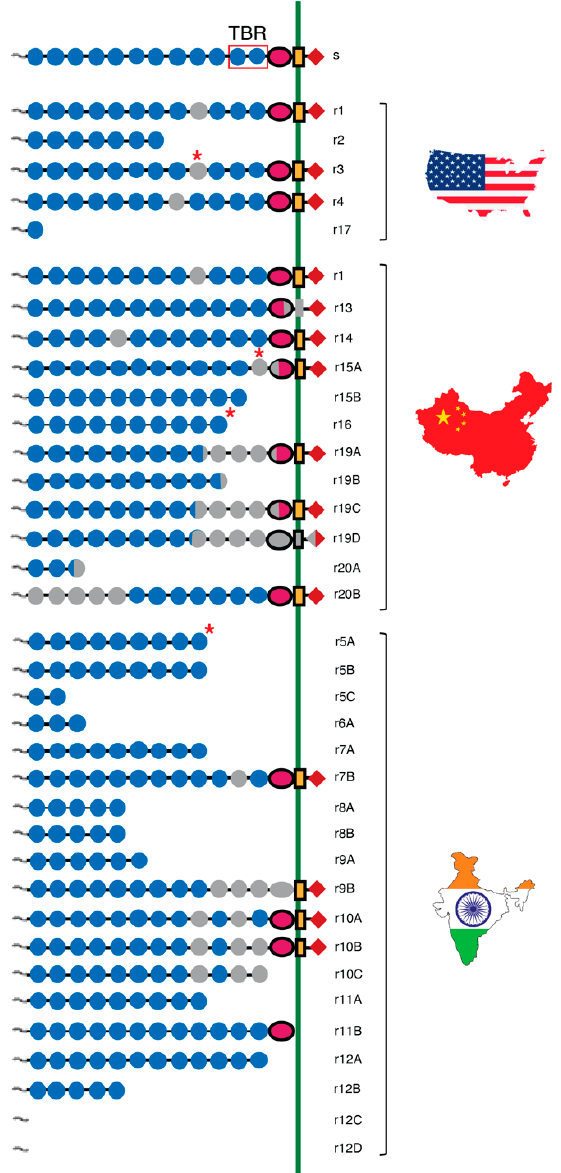
Figure 3. Cadherin protein variants encoded by wild-type ( s ) and 19 mutant resistance alleles ( r1 – r17 and r19 – r20 ) of the pink bollworm gene PgCad1 from the U.S., China, and India. Letters A – D following the numbers for resistance alleles indicate variation in cDNA for a given gDNA sequence (e.g., r15A and r15B ). The wild-type protein consists of the amino-terminal membrane signal sequence (~), cadherin repeats 1–12 (blue circles), membrane proximal region (purple oval), transmembrane region (orange rectangle), and cytoplasmic domain (red diamond). The open red box in the wild-type protein indicates the primary Cry1Ac toxin-binding region (TBR) in CR11 and CR12. Truncated structures show protein variants predicted from cDNA with premature stop codons. Gray in circles and ovals indicates missing regions caused by deletions or mis-splicing of pre-mRNA. The green vertical line represents the membrane of midgut epithelial cells with extracellular space to the left and cytoplasm to the right. Asterisks indicate transposon insertion sites (see Section 4.2.3).